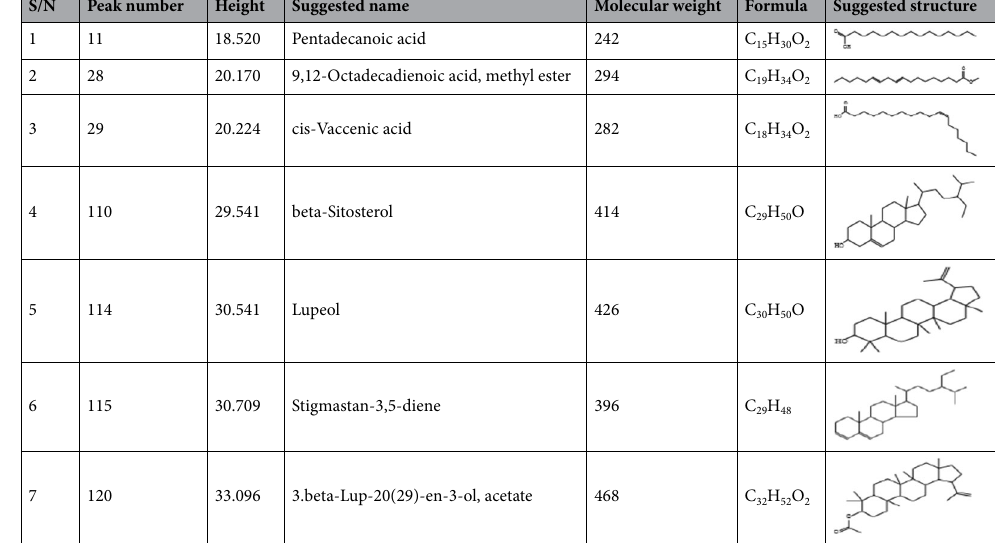
Suggested name Molecular weight Formula Suggested